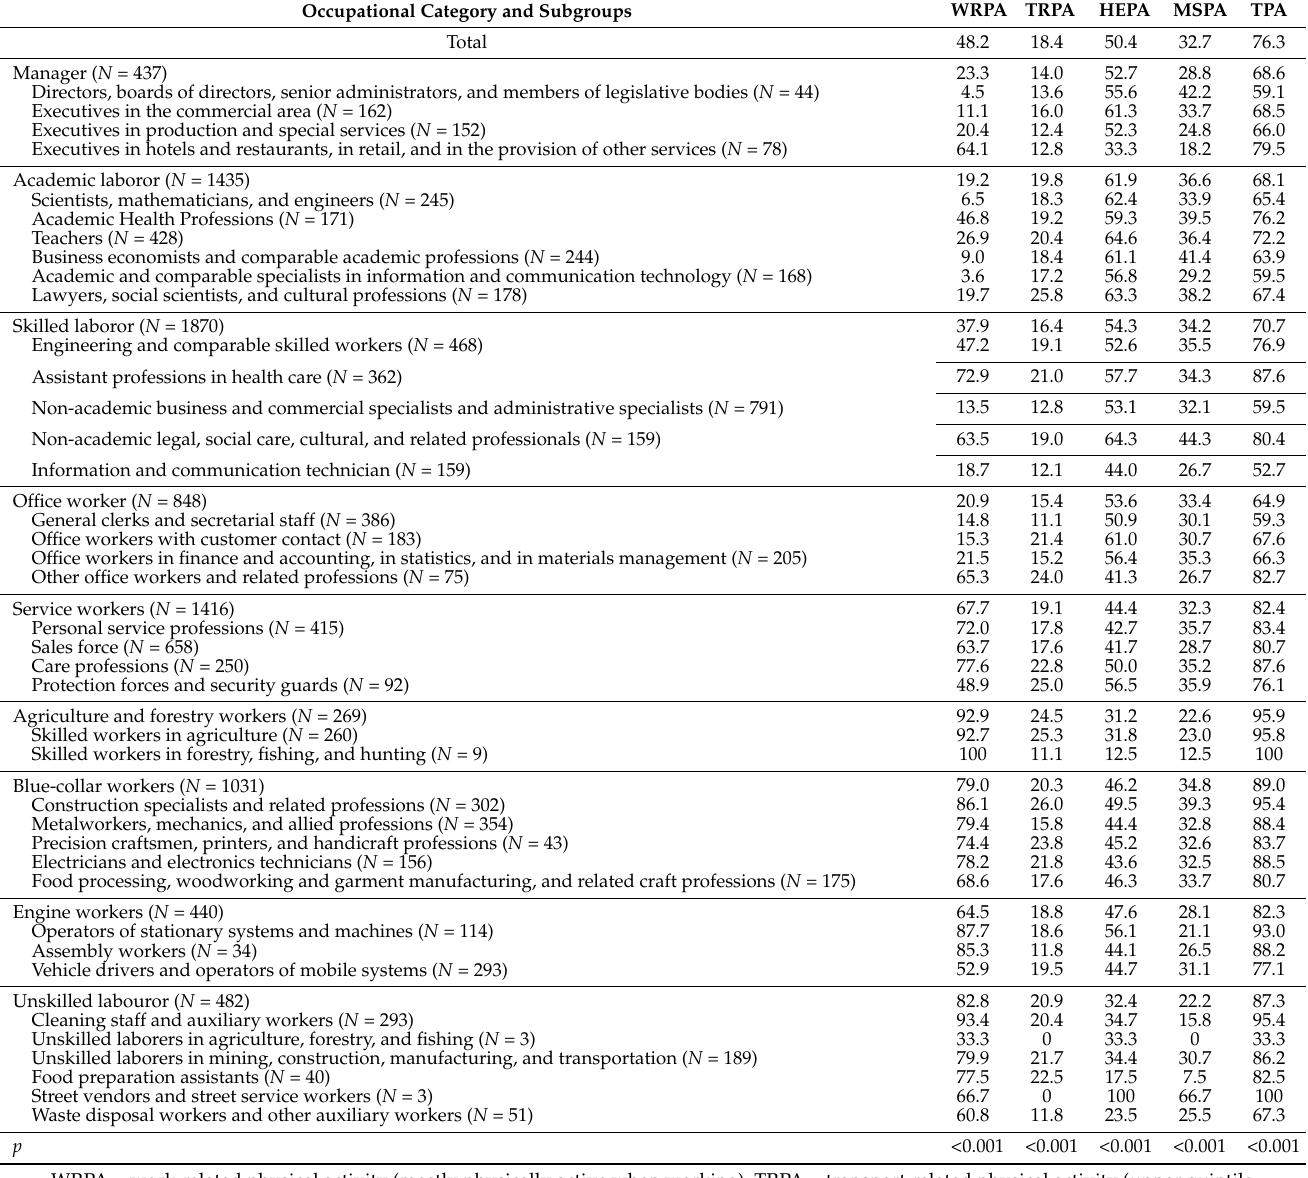
Table 2. Proportion of people who reached the respective thresholds in the different domains of physical activity among gainfully employed persons in Austria in 39 different occupational